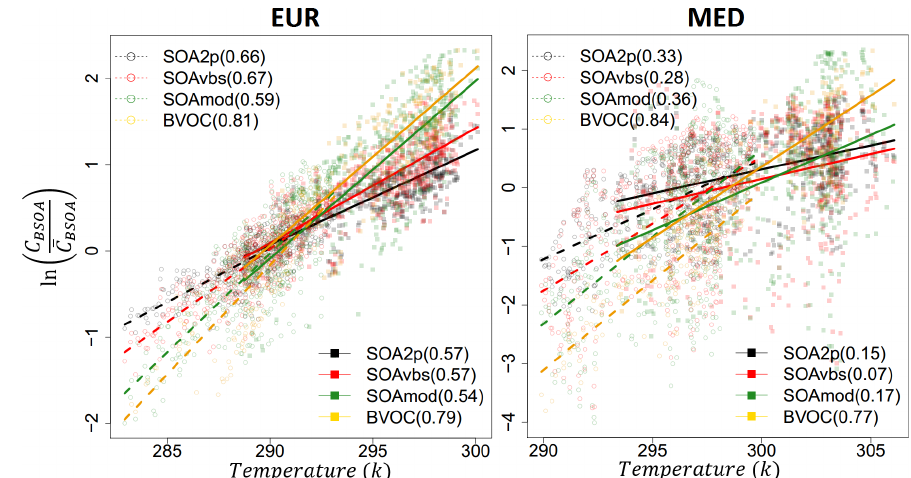
Figure 7. Normalized (divided by the average) concentrations of BSOA versus temperature for the summer period (SOA2p in black, SOAvbs in red and SOAmod in green). Each point represents 1d of simulation. Empty circles and dashed lines show the historic period, while filled rectangles and filled lines show the future scenarios. The points concerning BVOCs have been added as well (in gold). The regression lines are exponential. The correlation coefficients for each of the schemes are reported in the legend. Emissions of BVOCs are kept constant between different schemes. A different scale is used for each sub-domain to facilitate the comprehension of the